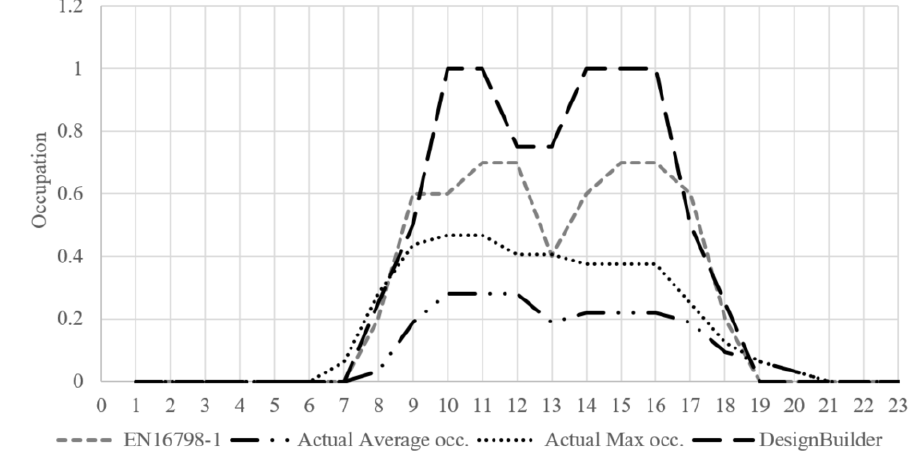
Figure 6. Daily human occupancy schedules.